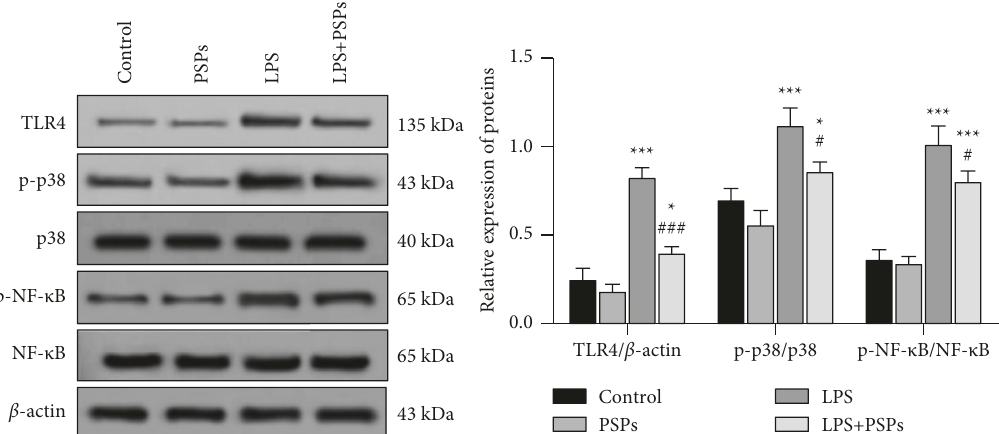
Figure 6: Effect of PSPs on the TLR4-MAPK/NF- κ B signaling pathway. Compared with control group,